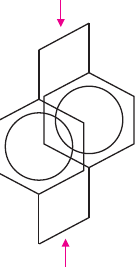
Figure 10. In the precursor diparylene, the two red arrows mark the breaking point of the molecule.